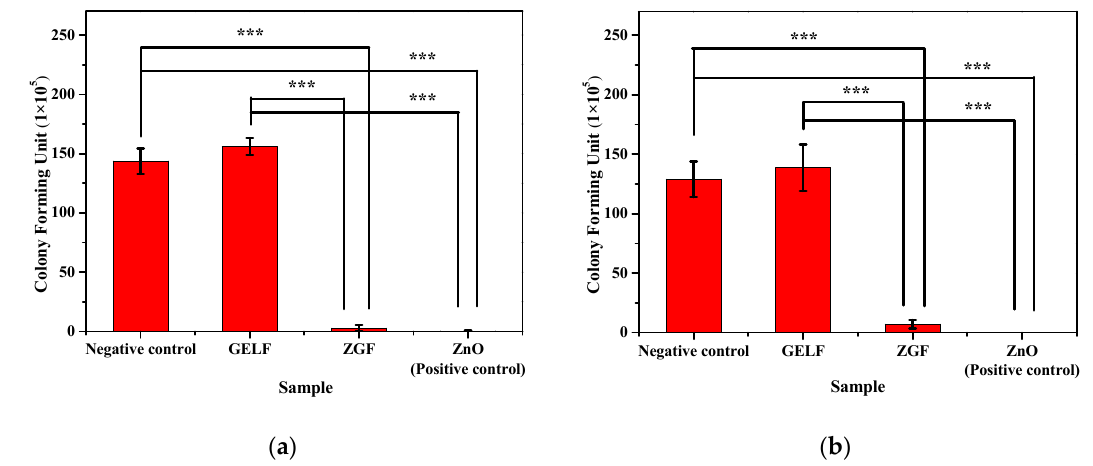
Figure 8. Antibacterial activities of negative control, GELF, ZGF and ZnO (positive control) to ( a ) E. coli and ( b ) S. aureus . (* represents p < 0.05, ** represents p < 0.01 and *** represents p < 0.001).